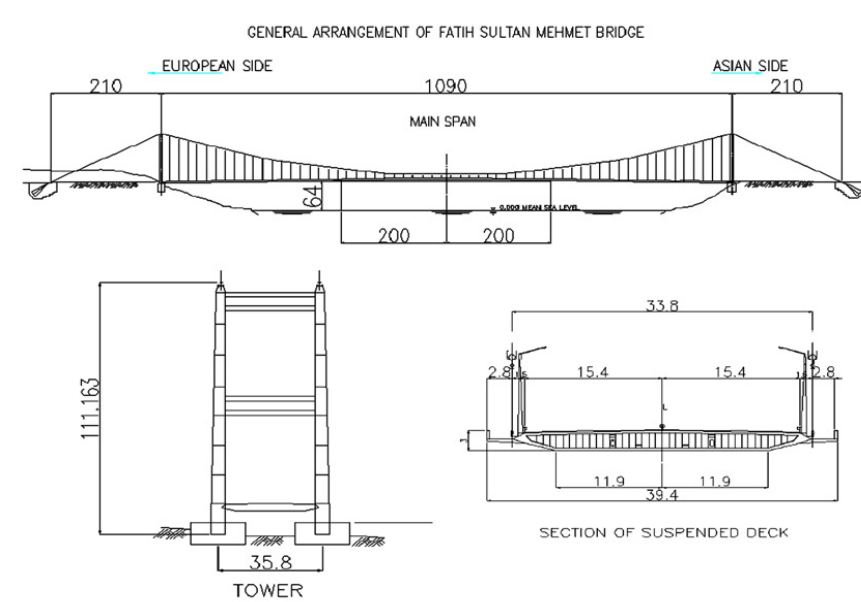
Fig. 10. General arrangement of Fatih Sultan Mehmet Suspension Bridge. Fig.10. General arrangement of Fatih Sultan Mehmet Suspension Bridge